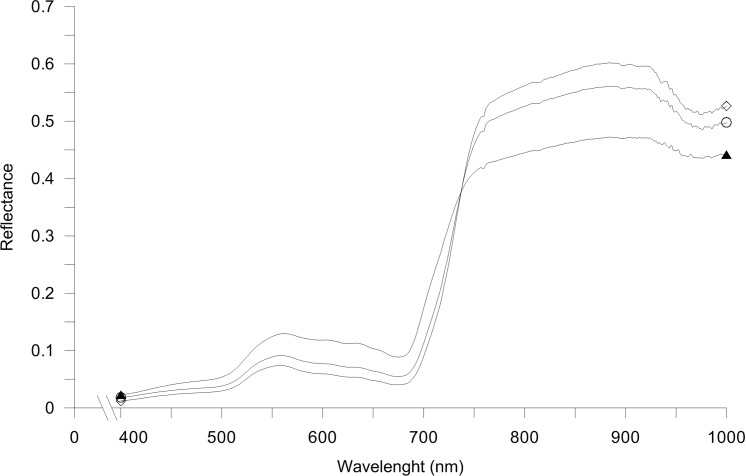
Canopy reflectance of durum wheat plants (averaged over DC65, DC71, DC75 and DC77 phenological stages).Durum wheat plants were exposed to control conditions (unfertilized CONTROL, black triangle) and to N fertilization treatments with urea (UREA, white rhombus) and calcium nitrate (NITRATE, white circle) at the rate of 150 kg N ha-1, in 2012.